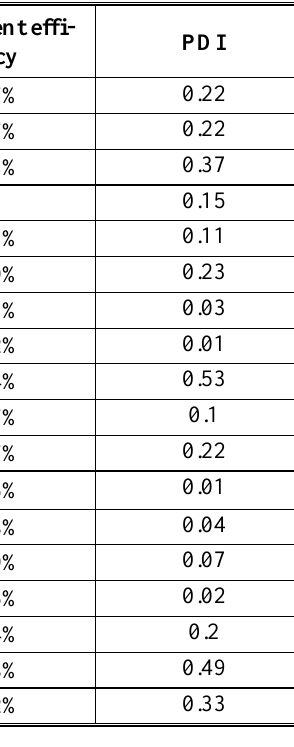
Table4. Particle Size, Zeta Potential, PDI and Entrapment Efficiency of Darifenacin Hydrobromide Loaded